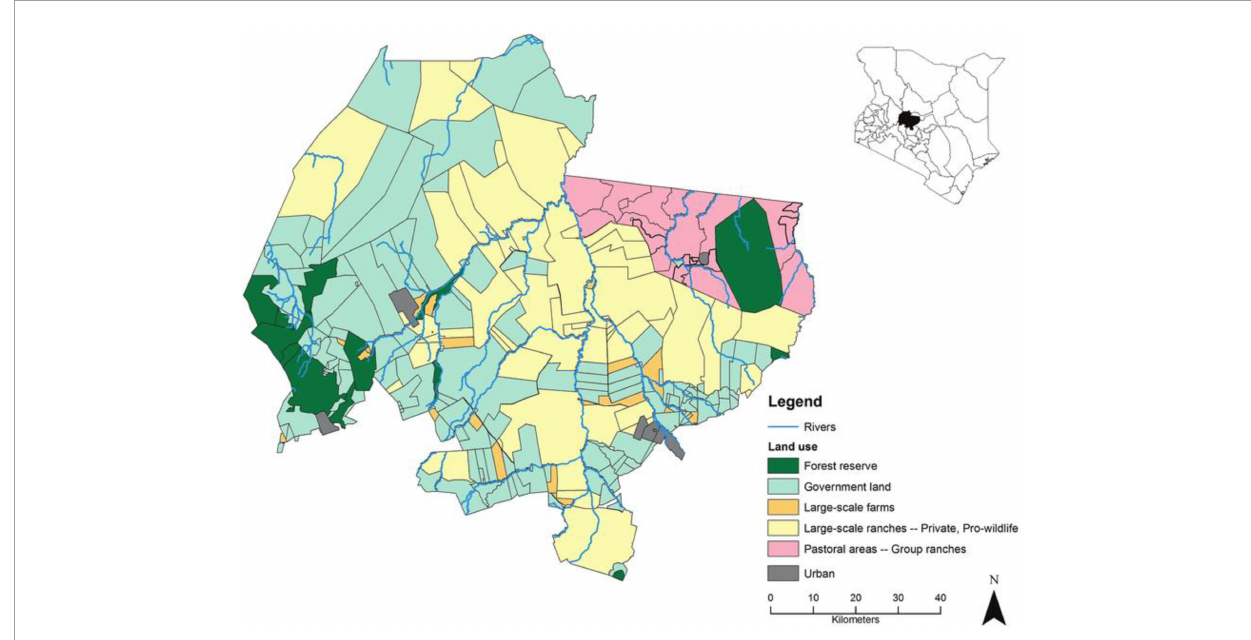
FIGURE1 Land use patterns of Laikipia County, Kenya. Most wildlife occurs on the large scale commercial ranches/conservancies, government land is occupied by smallholder farmers or pastoralists, group ranches are communally owned pastoralist communities, the forest reserves are heavily grazed by